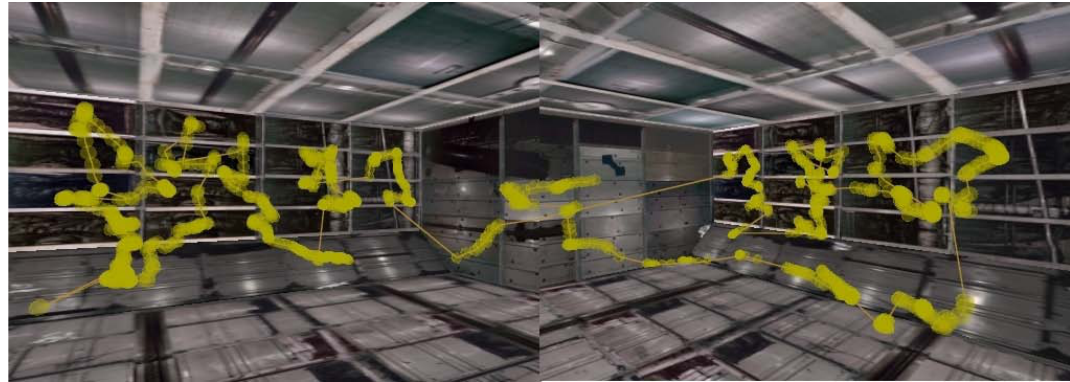
Figure 9. “Fixation Points for F.F.S.P.L.”. Source: Own contribution.